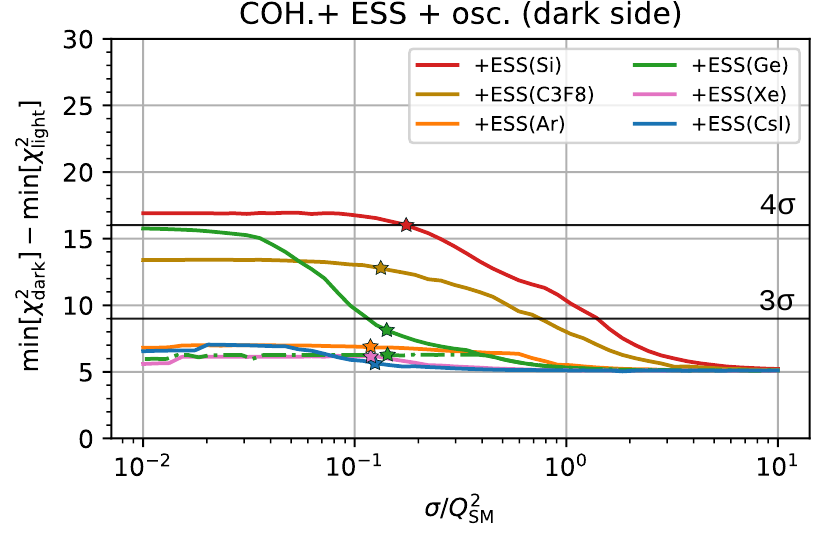
Figure 5 . ∆ χ 2 between the LMA-dark and LMA-light best-fit points as function of the relative measurement error σ/Q 2 for a CE ν NS experiment at a stopped pion source for different target SM materials, assuming that the best-fit point corresponds to no NSI. In scaling σ we keep the ratio σ µ /σ constant, using the value given in table 1. The dashed-green curve shows the result for Ge for σ µ → ∞ . The stars indicate the assumptions for ESS sensitivities based on